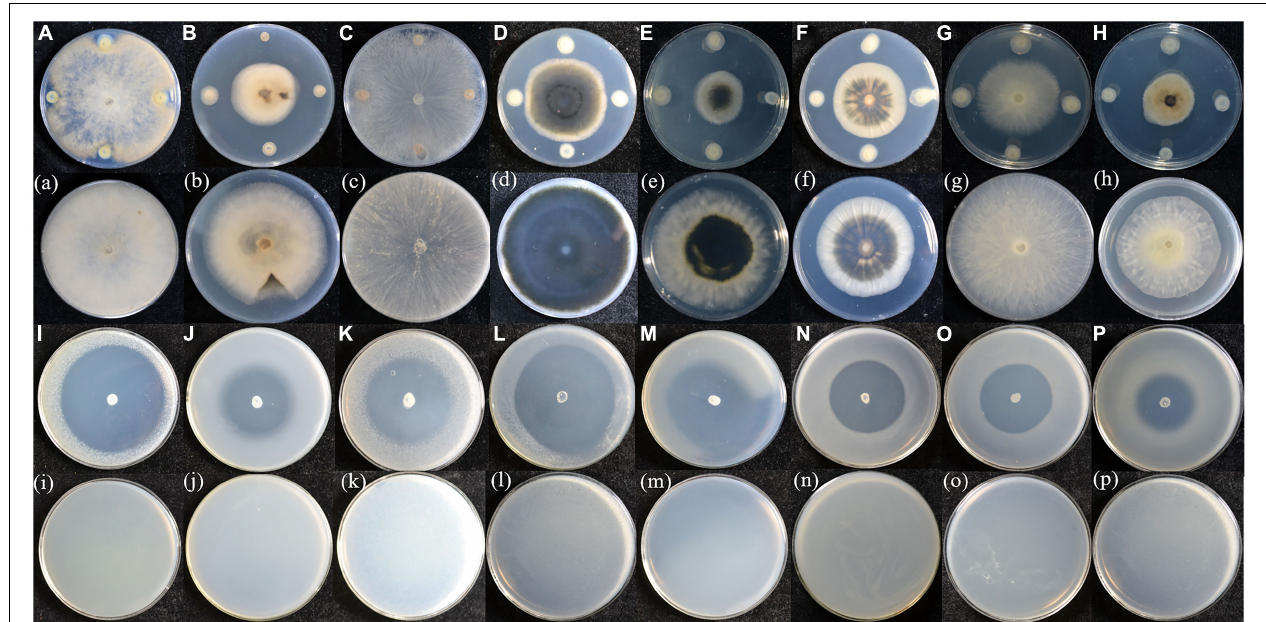
FIGURE 1 | Antagonistic assays of R. aceris ZF458 against various plant fungal and bacterial pathogens. (A,a) Botrytis cinerea , (B,b) Stemphylium solani , (C,c) Rhizoctonia solani , (D,d) Corynespora cassiicola , (E,e) Ascochyta citrulline , (F,f) Colletotrichum sp., (G,g) Fusarium oxysporum , (H,h) Phytophthora capsici , (I,i) Pectobacterium brasiliense , (J,j) Pseudomonas amygdali pv. lachrymans , (K,k) Pseudomonas syringae pv. tomato , (L,l) Ralstonia solanacearum , (M,m) Xanthomonas campestris pv. campestris , (N,n) Clavibacter michiganensis subsp. michiganensis , (O,o) Agrobacterium tumefaciens , (P,p) Acidovorax citrulli . The capital letters represent plate containing strain ZF458, the small letters represent